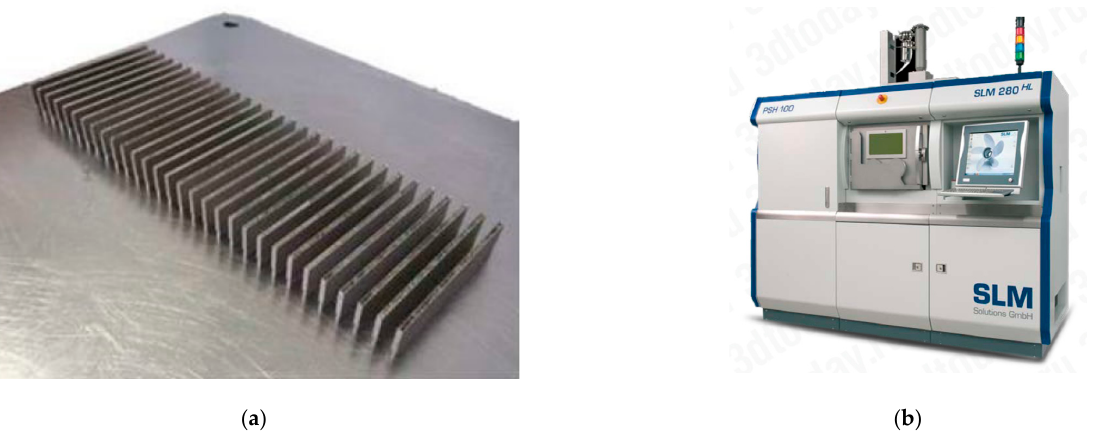
Figure 1. Samples from heat-resistant HN58MBYu alloy ( a ); Selective Laser Melting System ® 280HL ( b ). Table 1. Chemical composition of nickel–chromium HN58MBYu alloy in at.%.